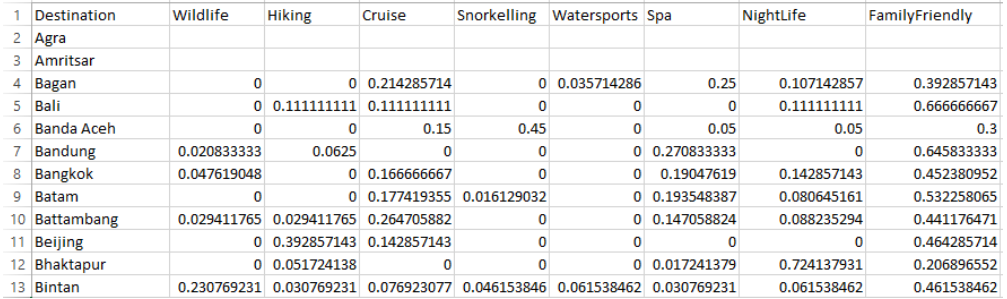
Figure 12. An output of thematic analysis of destination reviews.